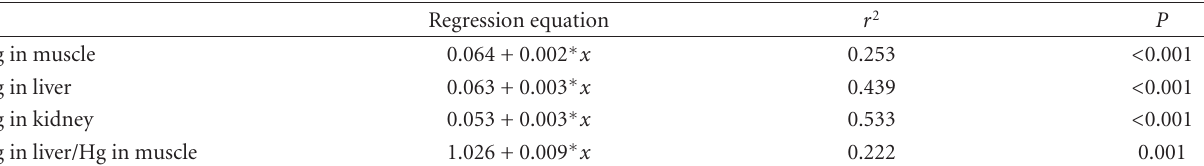
Table 5: E ff ect of cumulative amount of mercury intake ( x ) on mercury concentration in muscle, liver, kidney, and liver and muscle mercury concentration ratio. ( N = 45).